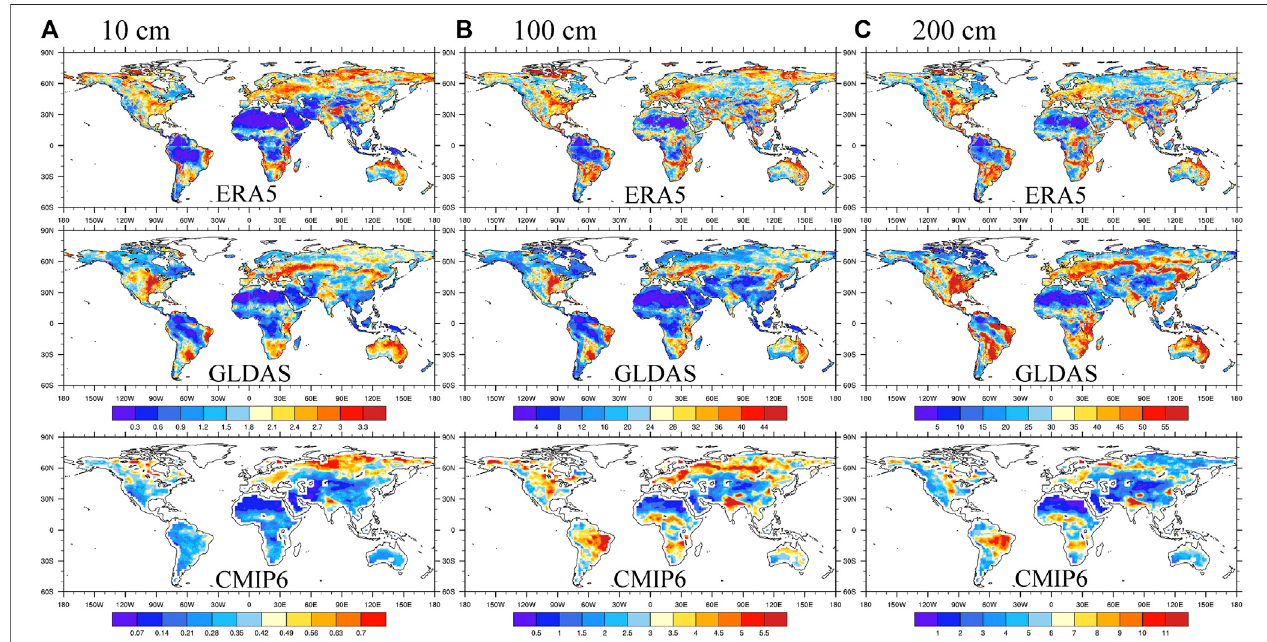
FIGURE 2 | Same as Figure 1 , but for standard deviation (kg/m 2 ) of soil